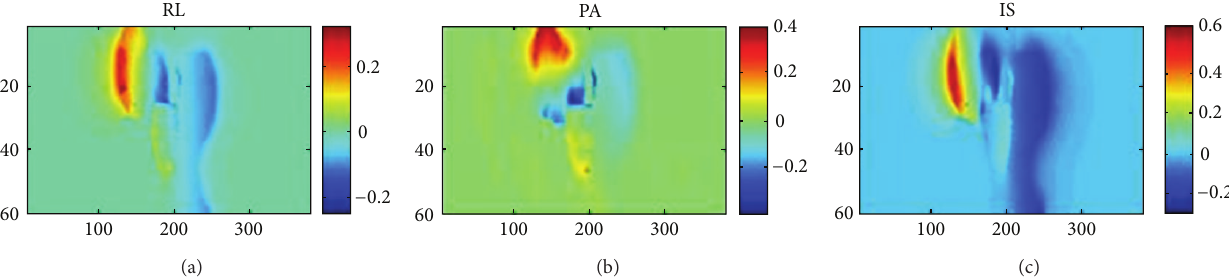
Figure 8: Color-coded difference maps for points in the tCT nonrigidly registered to the pCT using FEM and models. In the prostate ROI the agreement between the two methods is ∼ 1mm along the 𝑥 and 𝑦 axes and ∼ 2mm along the 𝑧 axis. The larger difference along the 𝑧 axis is attributed to the 3mm slice thickness.